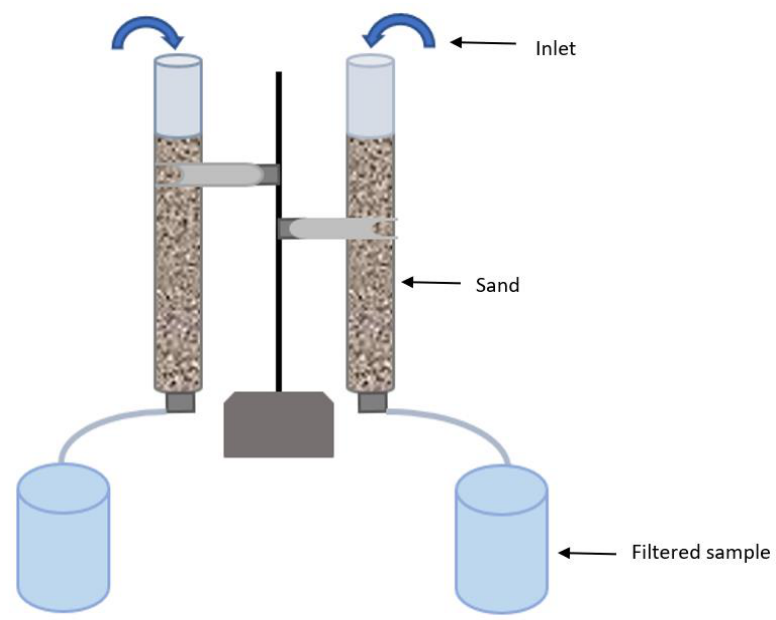
Figure 1. Sand-filter column for laboratory-scale